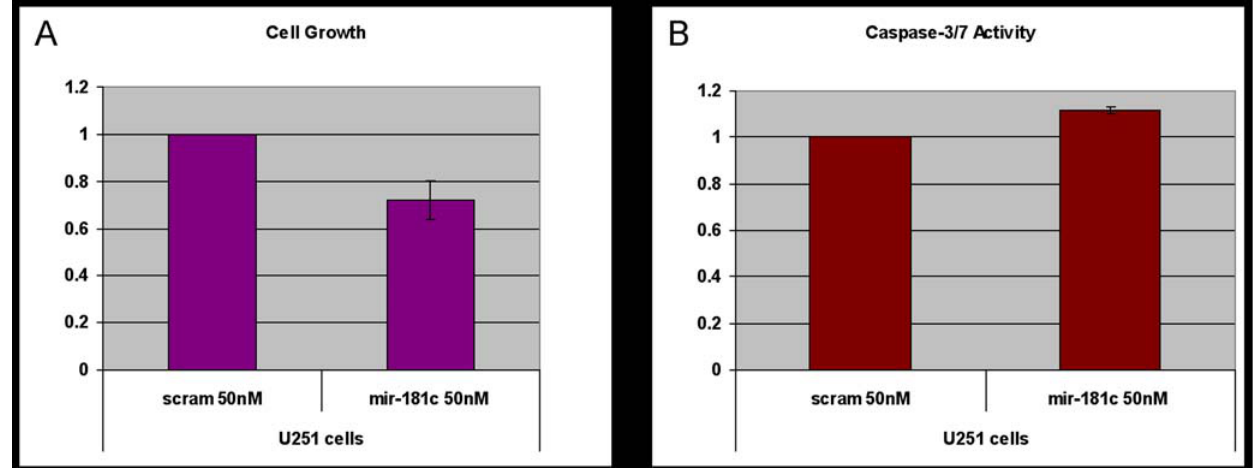
Figure 7. Cell Growth and Apoptosis Assays. U251 cells were treated with pre- miR-181c and negative control scramble. 24 hrs post-transfection, a) cell growth (p , 0.01, t-test) and b) apoptosis were assayed (p , 0.05, t-test).